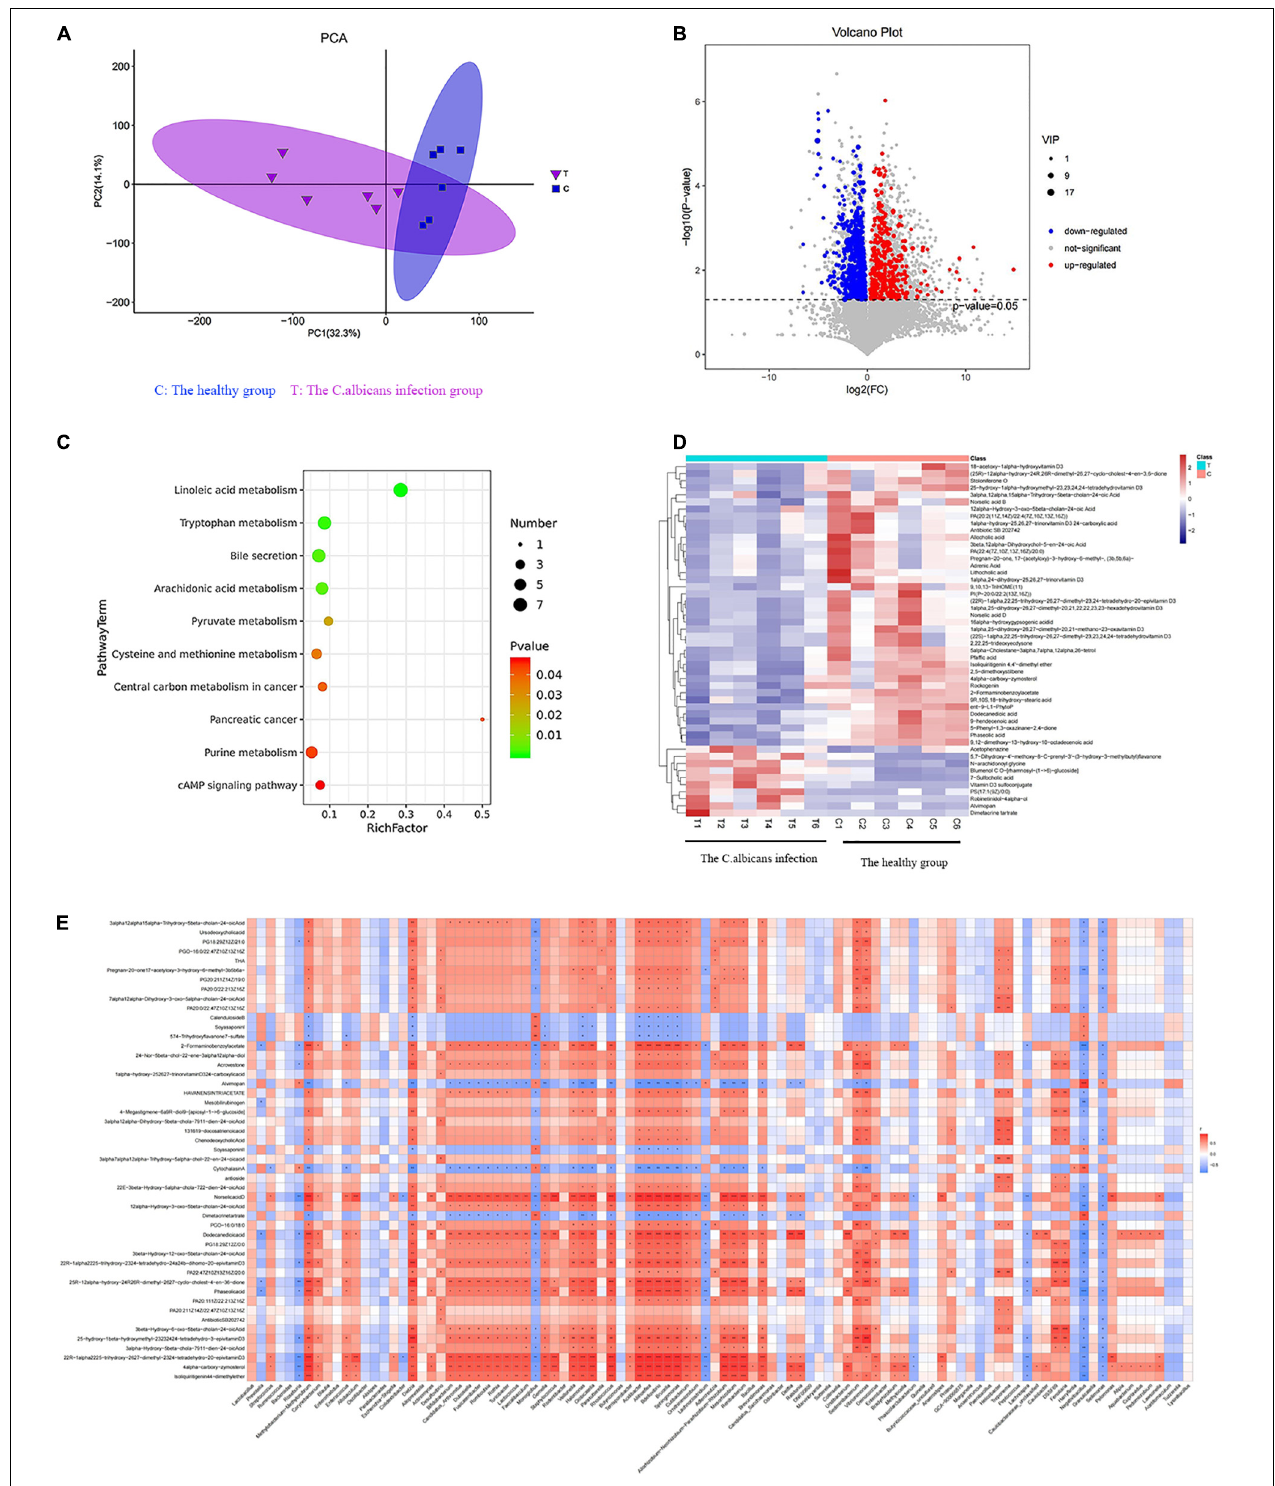
FIGURE 3 | Invasive C. albicans infection disrupts fecal metabolites in humans. (A) The PCA scatter plots of metabolomic analysis. (B) The volcano plot of differentially expressed metabolites. (C) The KEGG pathway enrichment analysis. (D) Heatmap of the top 50 differentially expressed metabolites. (E) Spearman correlation analysis. T, The Candida albicans infection group; C, The healthy control group.